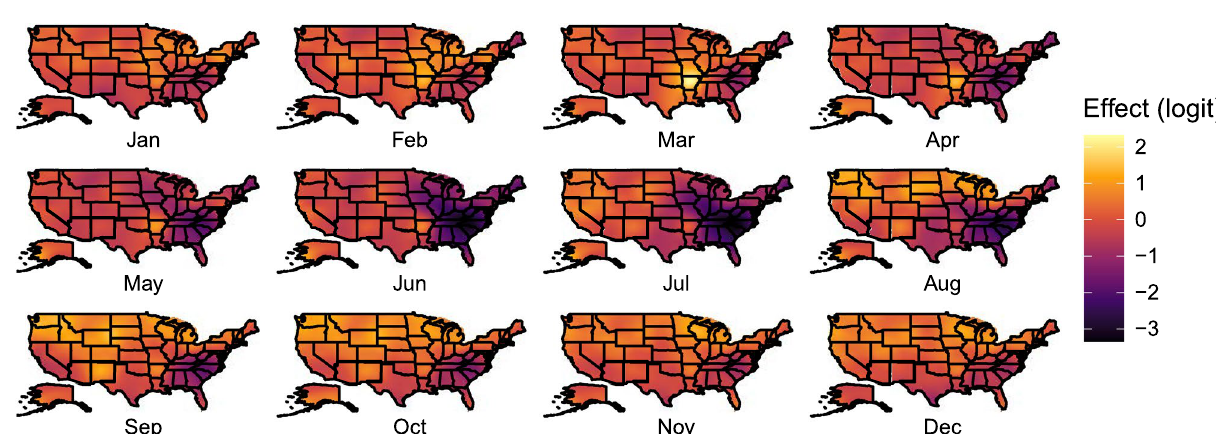
Figure 3. Monthly realizations of the spatial random field for the continental United States. Brighter colors indicate locations within a month with relatively greater IAV prevalence. Maps were produced in ggplot2 68 . Maps of the standard deviation can be found in Supplementary Fig. S3